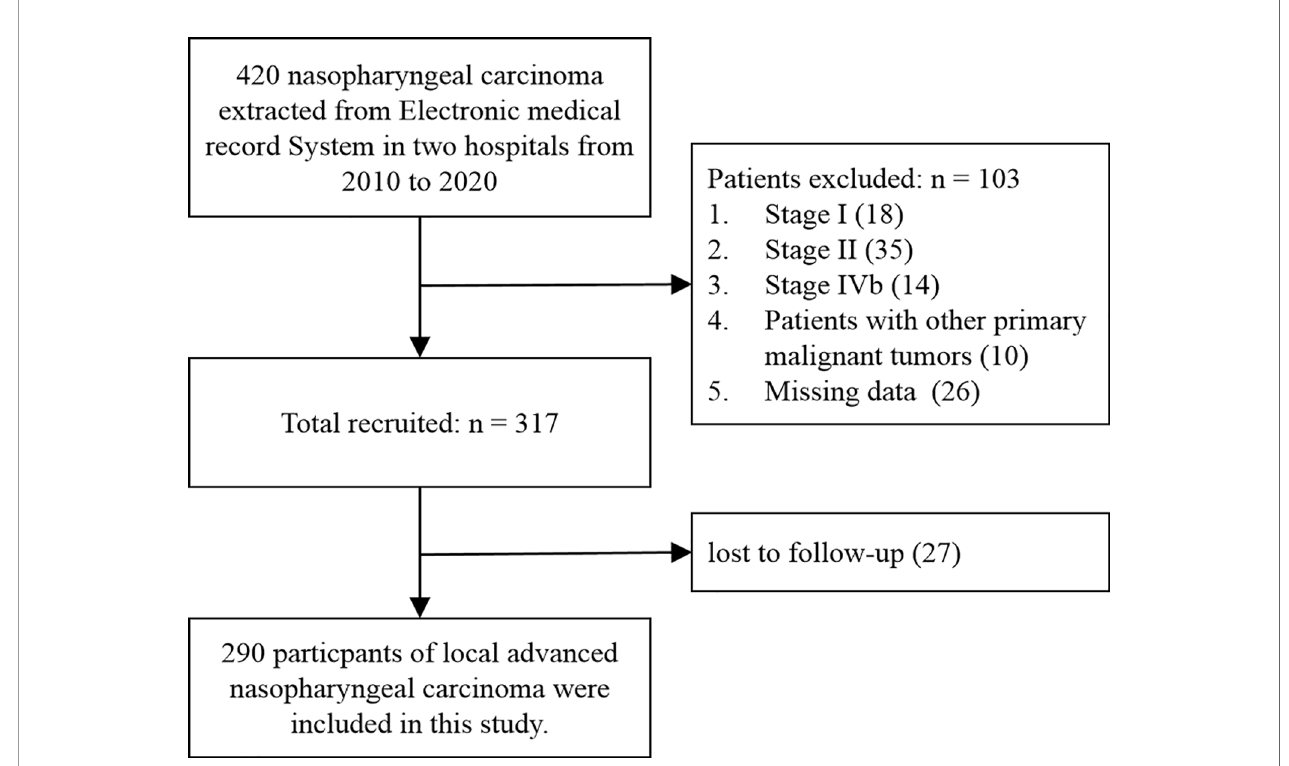
FIGURE 1 | Flow diagram of the study selection